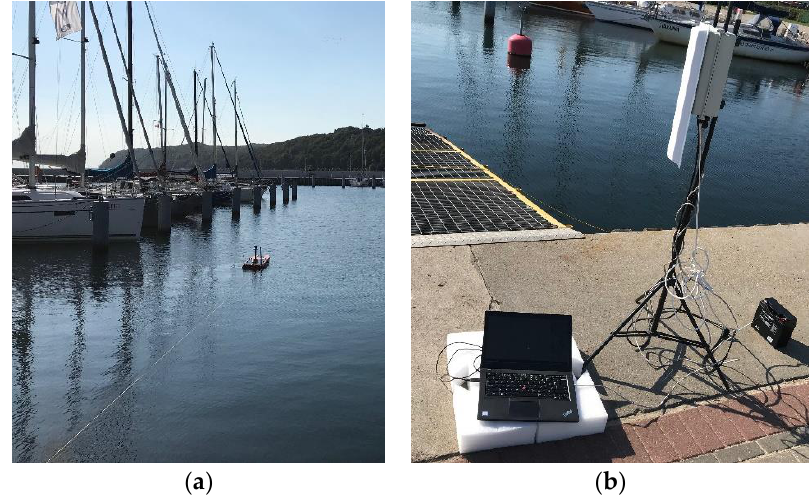
Figure 11. ( a ) USV during a collection data phase; ( b ) wireless control system.